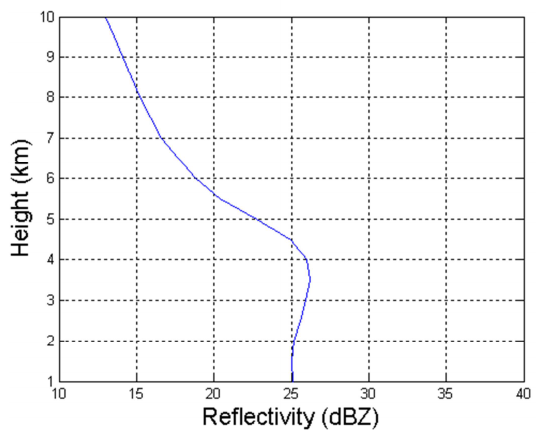
Fig. 11. Radar Reflectivity Factor vs. Height. Data from year 2009.